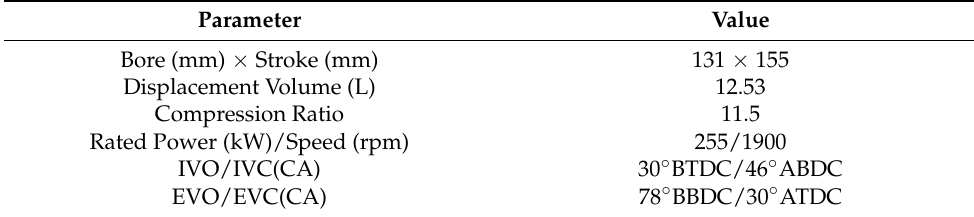
Table 2. Specifications of engine.